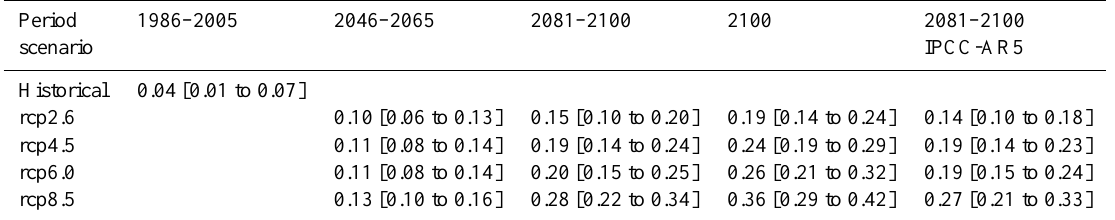
Table 1. Median and its 90% confidence interval for projections of global mean thSLR (in m) in 2046–2065 and 2081–2100 relative to 1986–2005 as well as in year 2100 relative to year 1900 for the four RCP